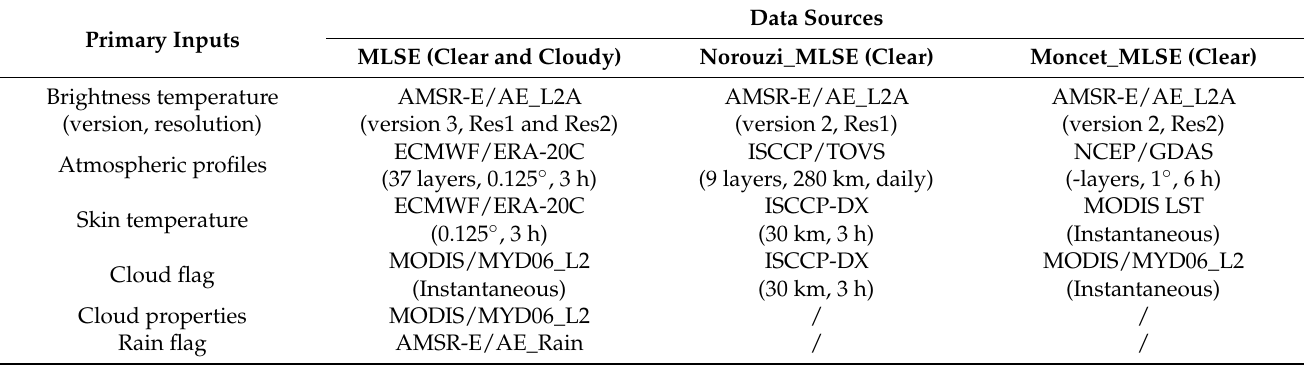
Table 2. Data sources of three AMSR-E emissivity products discussed in this